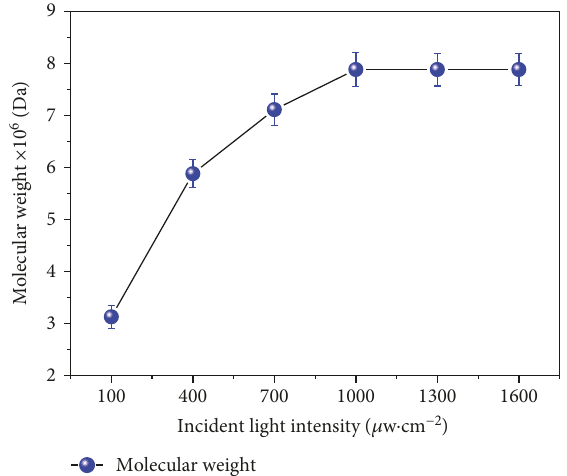
Figure 7: E ff ect of incident light intensity on the molecular weight of PAD.